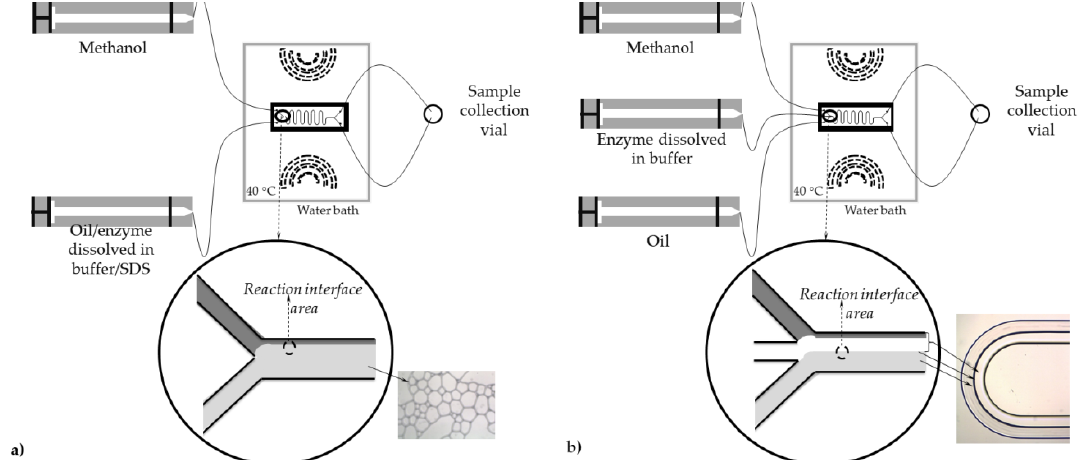
Figure 1. Schematic diagram of the microreactor system with ( a ) two inlets and ( b ) three inlets together with picture of formed flow pattern .